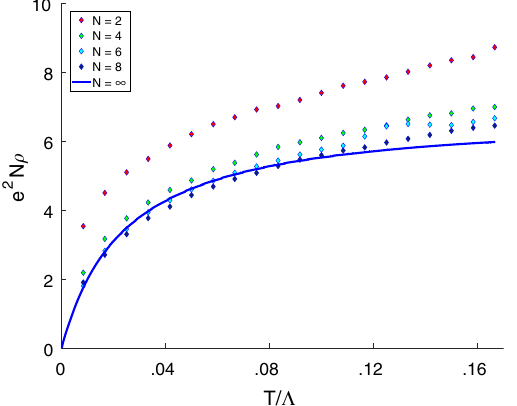
Fig. 6 Numerical results for the resistivity as a funciton of temperature. These results were obtained using a Monte